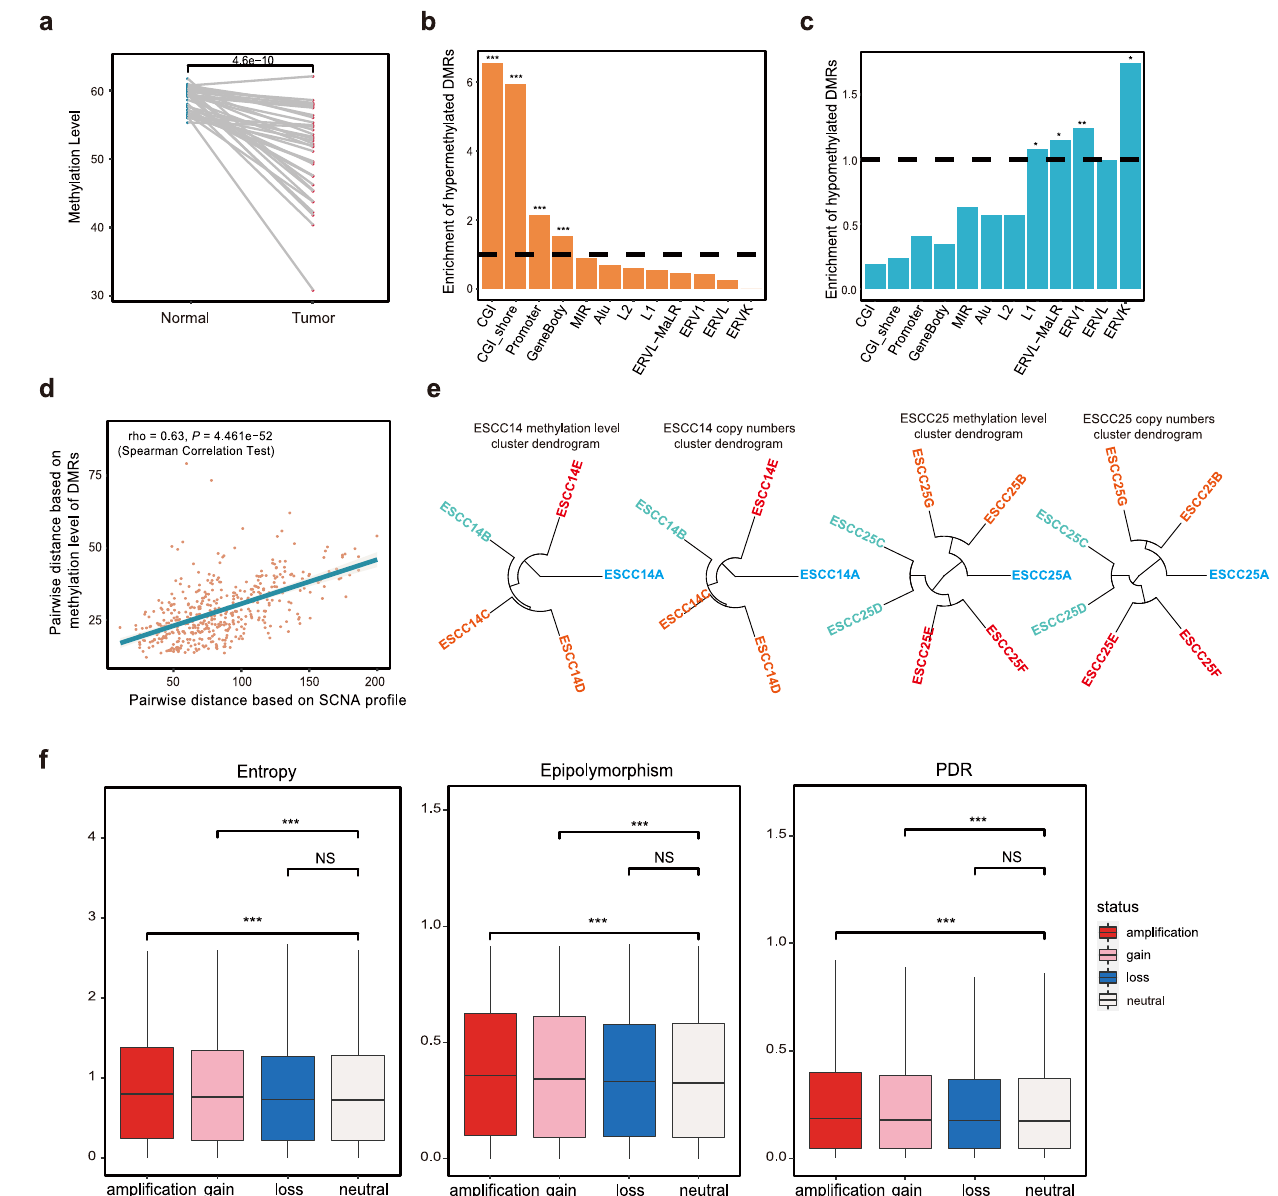
Fig. 2 | Fuels of epigenetic ITH in ESCC. a Methylation level comparison between paired Tumor ( n =186) and adjacent normal ( n =36) samples. Two-sided paired t test is used for comparison. b , c Enrichment of hypermethylated DMRs ( b ) and hypomethylated DMRs ( c ) for annotated genomic elements between tumor ( n =186)andpairednormal( n =36)samples.* P <0.05,** P <0.01,*** P <0.001;two- sided Fisher ’ s exact test. d The pairwise distance of tumor samples from the same patient is based on the DMRs and SCNA pro fi les. Each dot represents a pair of tumorsamplesfromthesamepatient.Spearman ’ scorrelationcoef fi cient(rho)and corresponding P -value isshown( n =452tumorregionpairs).Lineof best fi tshown